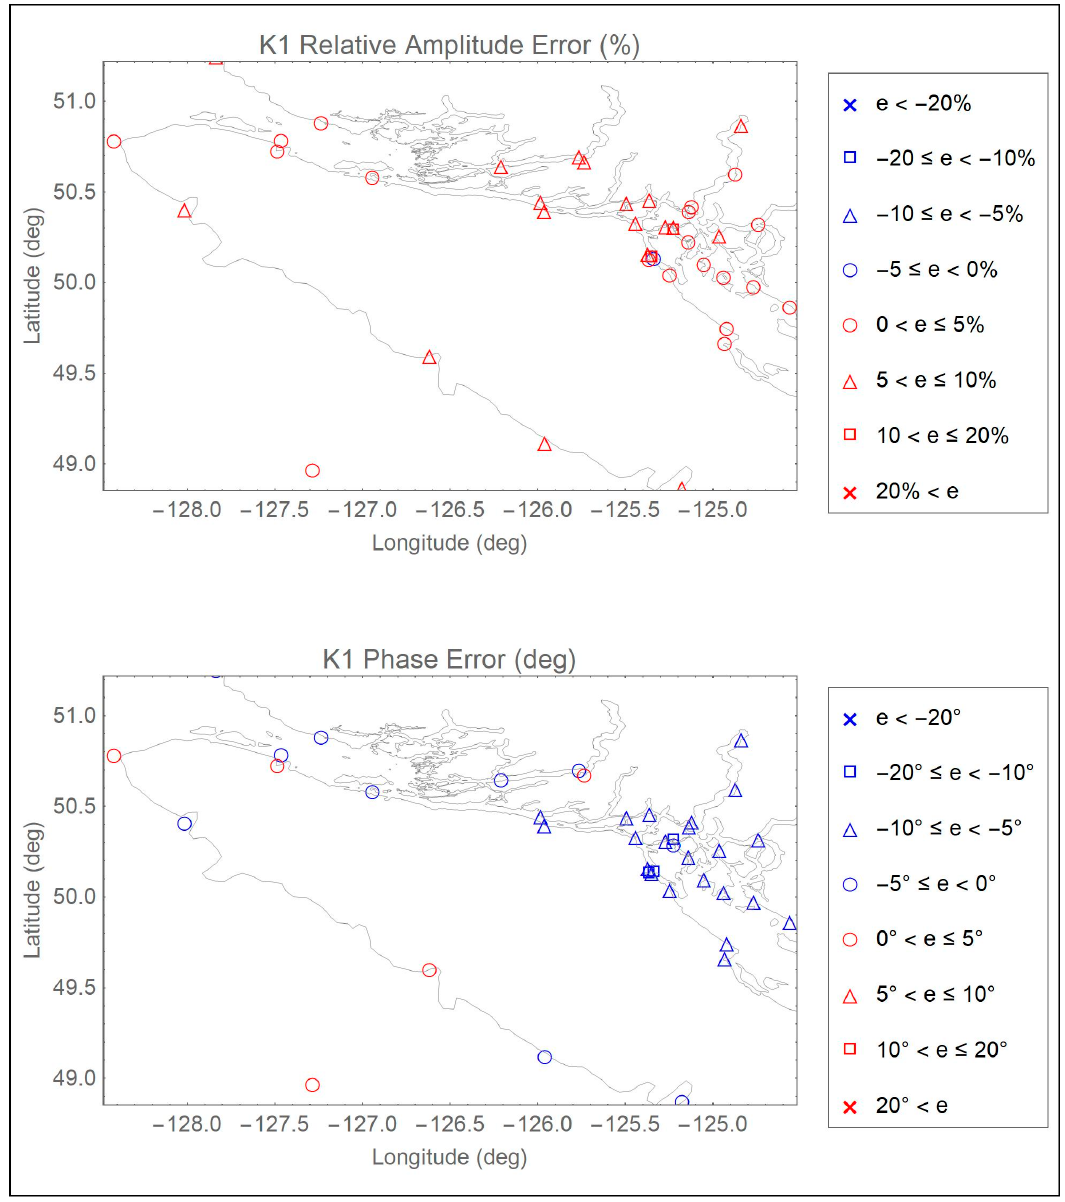
Figure A22. Distribution of ENPAC15 relative amplitude (%) and absolute phase (deg) errors for